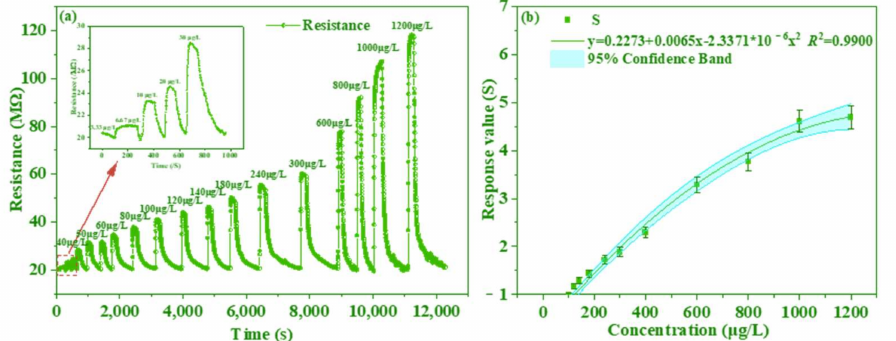
Figure 7. Resistance transients ( a ) and sensitivity ( b ) of the AgNWs sensor exposed to TMA of different concentrations at 25 ◦